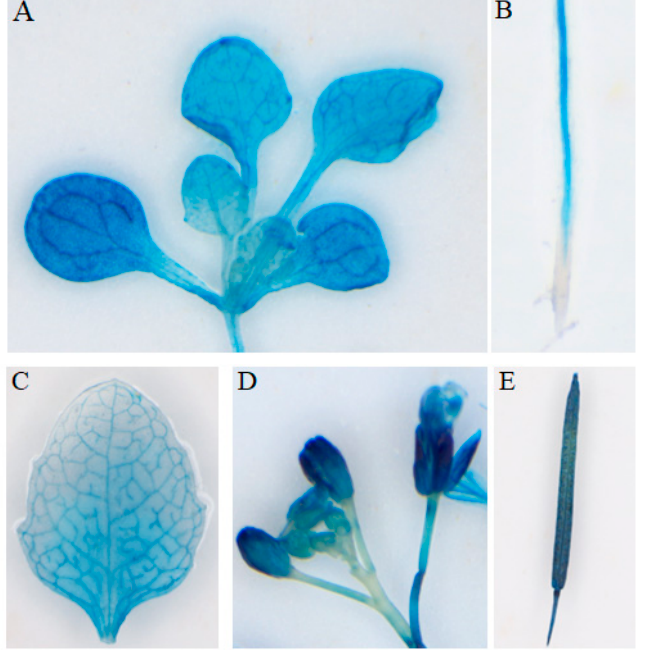
Figure 6. GUS activity in transgenic Arabidopsis plants expressing the GUS reporter gene un- der the control of PgrABCG14 promoter. ( A ) 10-day rosette leaves, ( B ) root, ( C ) 45-day-old leaf, ( D ) inflorescences, ( E )